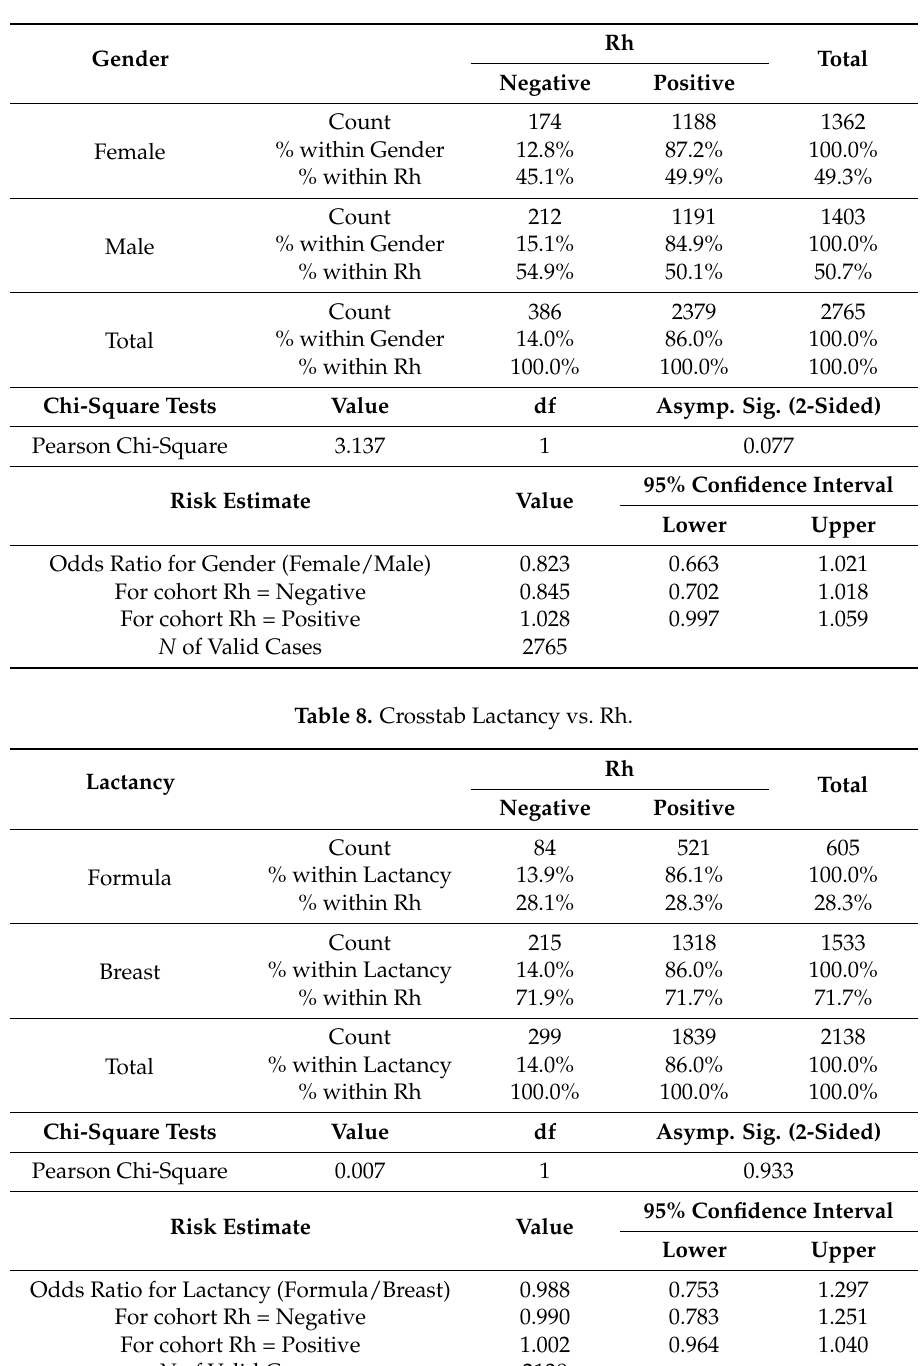
Table 7. Crosstab Gender vs. Rh.